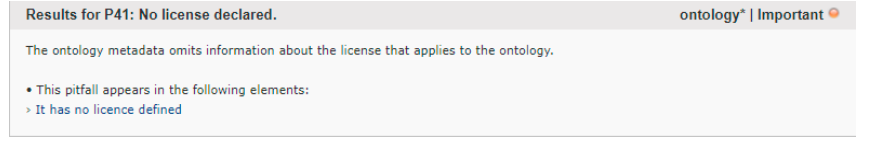
Figure 10. No license declared.